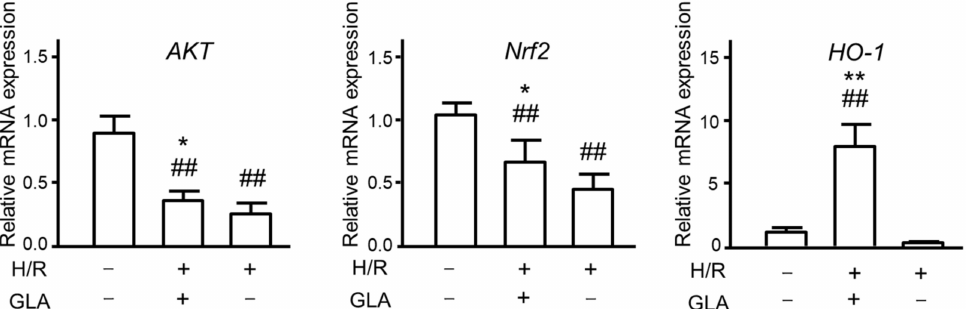
Figure 3. Effects of GLA on oxidative stress in HK-2 cells exposed to H/R. The cells were pre-treated with 5 µ M GLA for 2 h and then exposed to H/R for 24 h. ## p < 0.01, vs. control (normoxia); * p < 0.05; ** p < 0.01, vs.